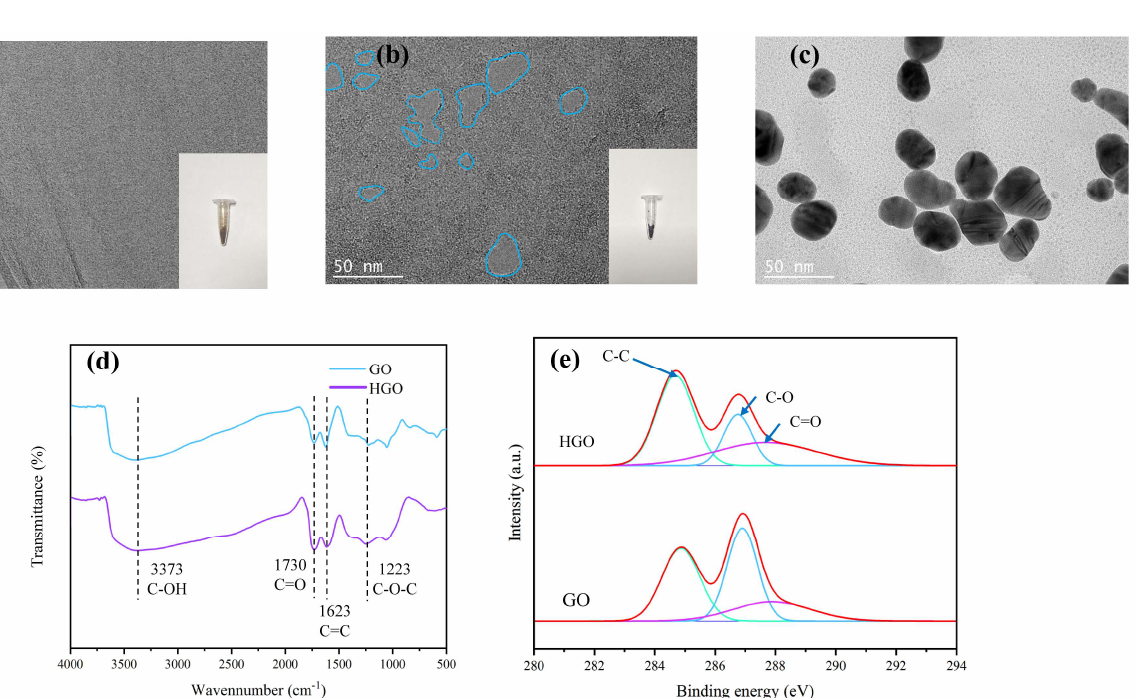
5 of 11 Figure 1. Schematic diagram of detection based on functionalized QCM sensor chip.